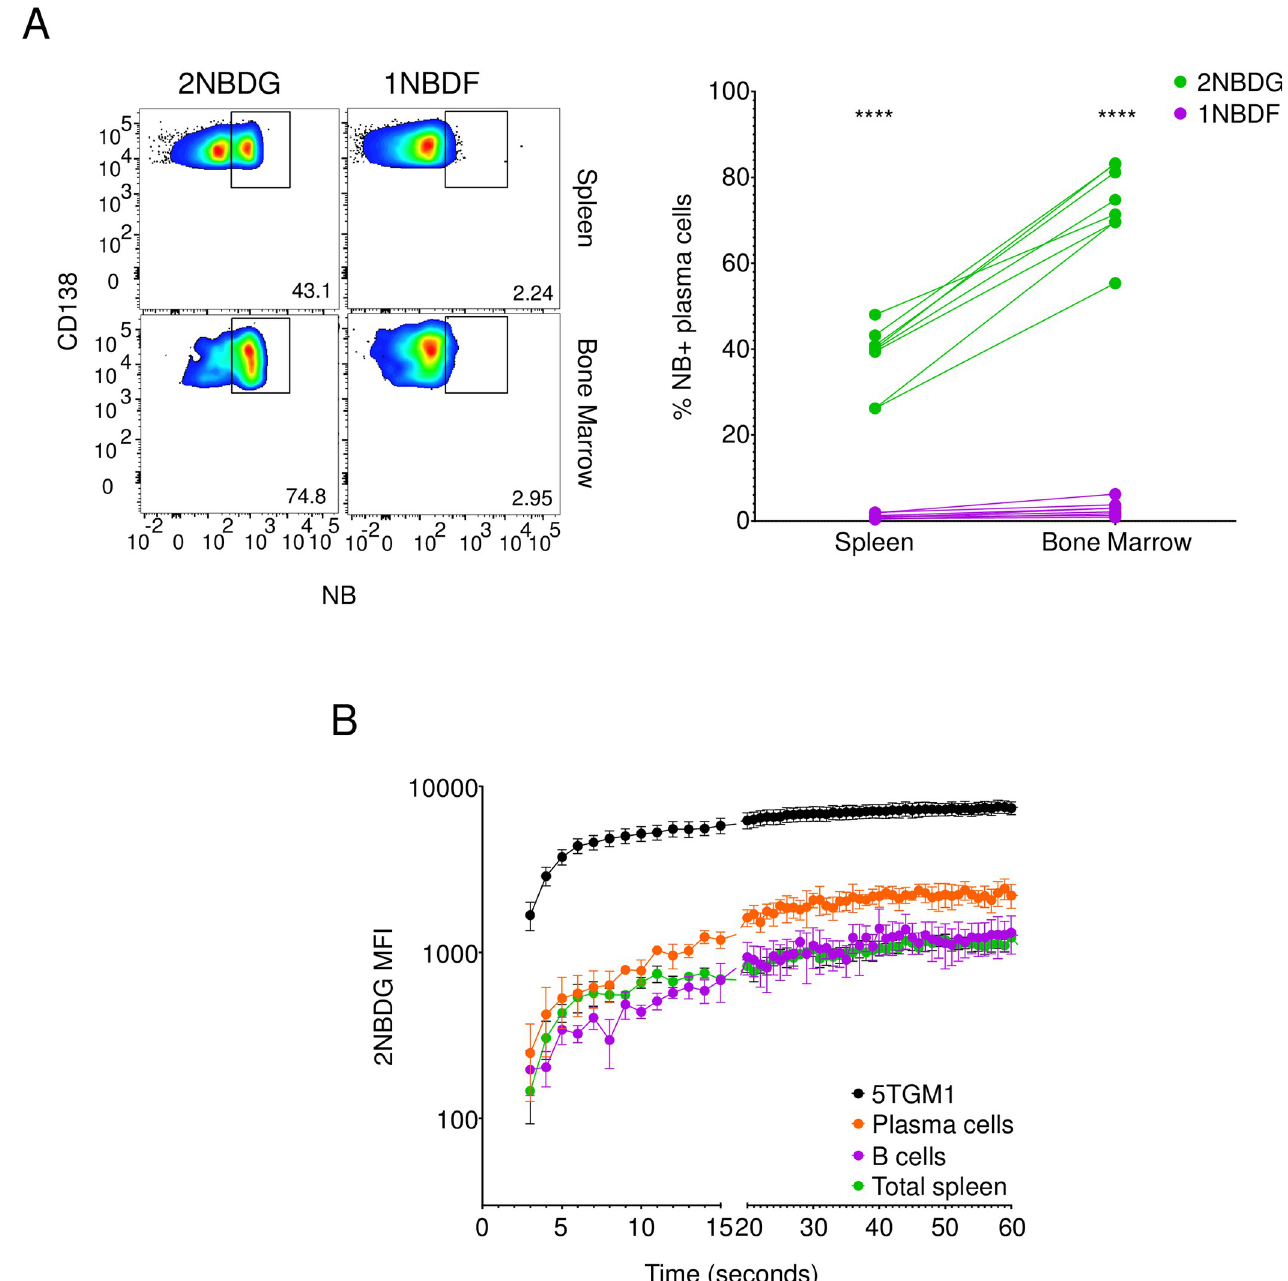
Fig 3. Plasma cells specifically transport 2NBDG. (A) Mice were injected with 100 μ g of either 2NBDG or 1NBDF and assessed for NB fluorescence in splenic and bone marrow plasma cells. Representative flow cytometry plots (left) on splenic (top row) and bone marrow (bottom row) CD138+ plasma cells showing gated percent NB-positive cells. Quantification of NB-positive plasma cell percentages (left) in the spleen and bone marrow and groups from each mouse are connected by a line. Data from three independent experiments with n = 8 mice in both groups. ���� p < 0.0001 by ordinary two-way ANOVA with post hoc Sˇı´da´k’s multiple comparison test. (B) Freshly isolated ex vivo plasma cells (CD138+ B220+/-, orange), B cells (CD138- B220+, purple), and total spleen cells (green) as well as cultured 5TGM1 cells (black) were examined for 2NBDG uptake by flow cytometry. Pooled data from three independent experiments shown as mean+/-SEM for mentioned time